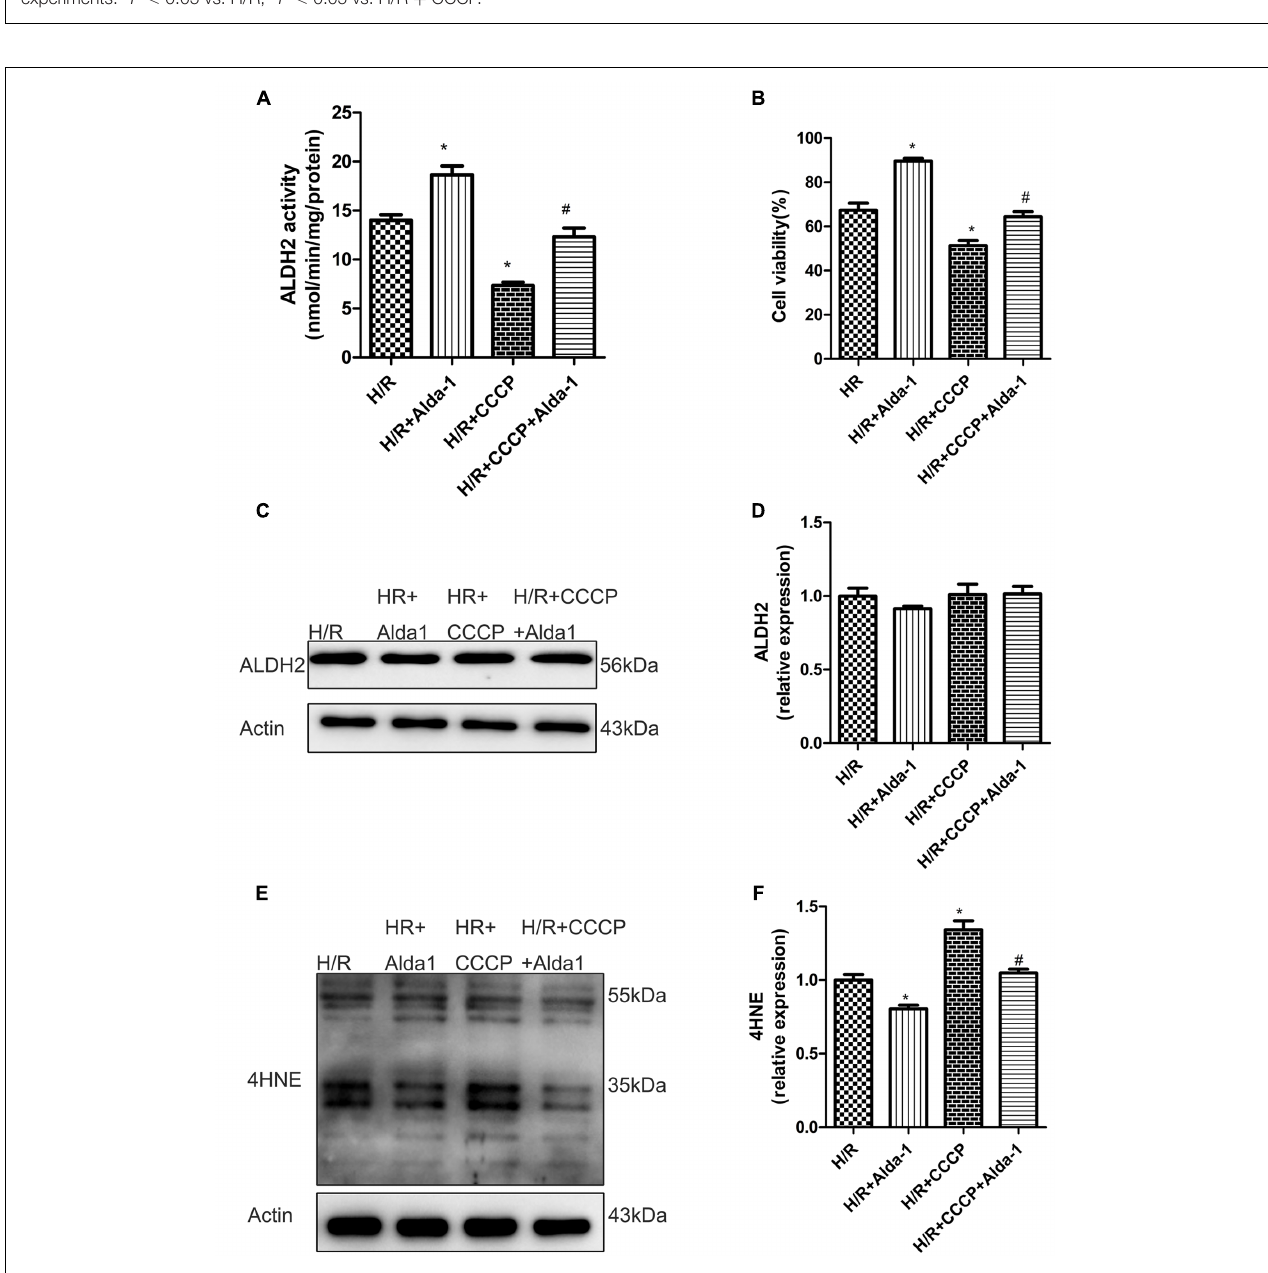
FIGURE 7 | Effect of CCCP on ALDH2 activity and expression, cell viability and 4HNE accumulation in H/R-treated H9C2 cells. (A) ALDH2 enzymatic activity ( P < 0.0001, One-way ANOVA). (B) Cell viability ( P < 0.0001, One-way ANOVA). (C) Representative gel blots of protein expression of ALDH2 and Actin (loading control). (D) Quantification analysis of ALDH2 expression ( P = 0.5138, One-way ANOVA). (E) Representative gel blots of expression of 4HNE. (F) Quantification analysis of 4HNE expression ( P = 0.001, One-way ANOVA). Data are mean ± SD from 3 independent experiments. ∗ P < 0.05 vs. H/R; # P < 0.05 vs. H/R +